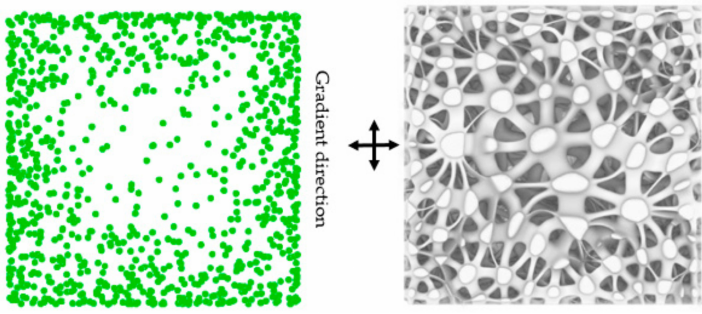
Figure 22. Structure with gradient seed and pore size imitating bone.